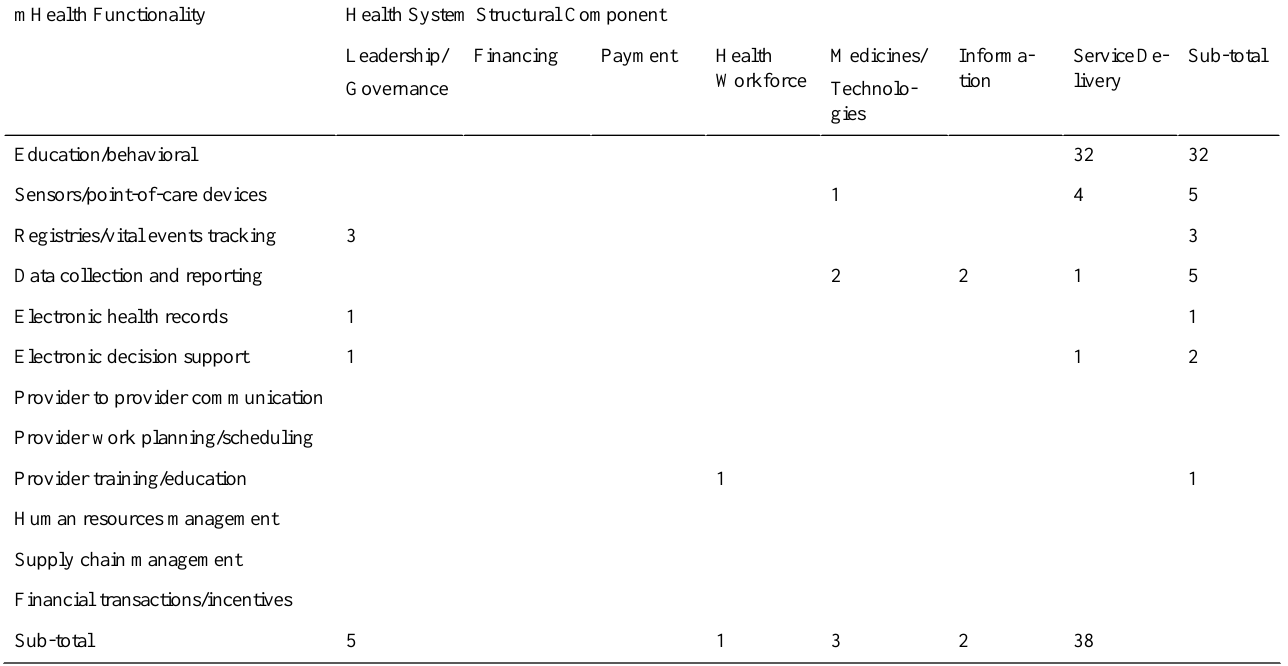
Table 2. Health system framework assessment of the mHealth interventions.